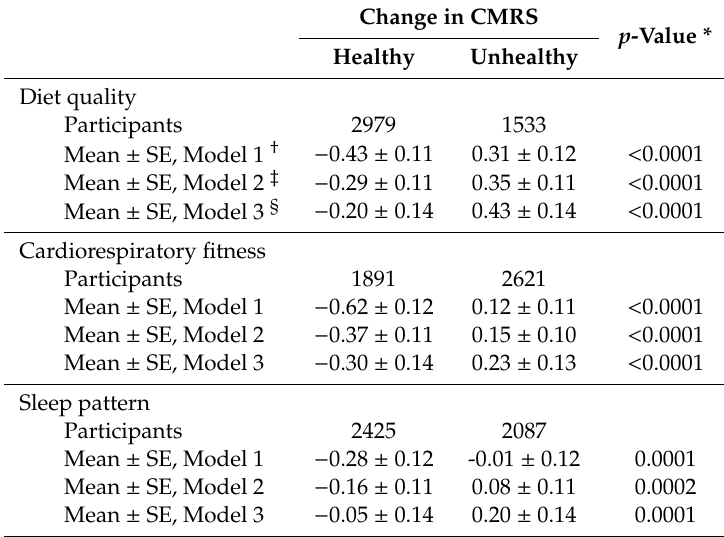
Table 3. Diet quality, cardiorespiratory fitness, and sleep pattern and changes in cardiometabolic risk score in